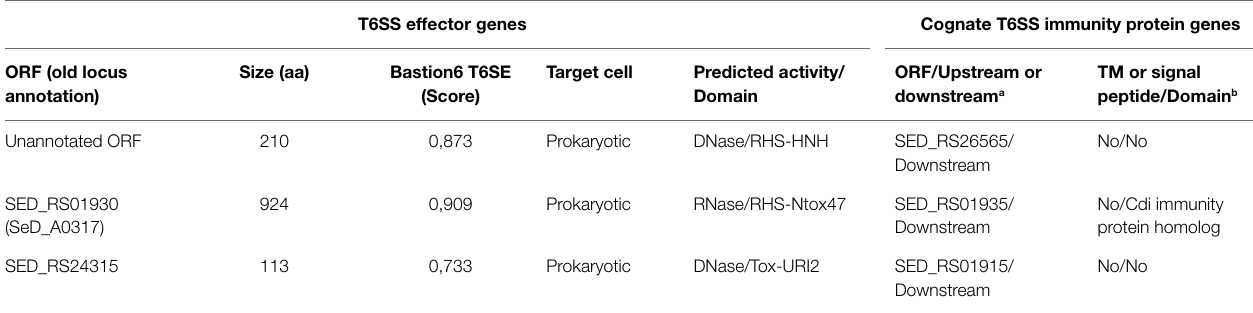
TABLE 3 | Novel predicted T6SS effectors and cognate immunity proteins encoded in SPI-6 of Salmonella Dublin